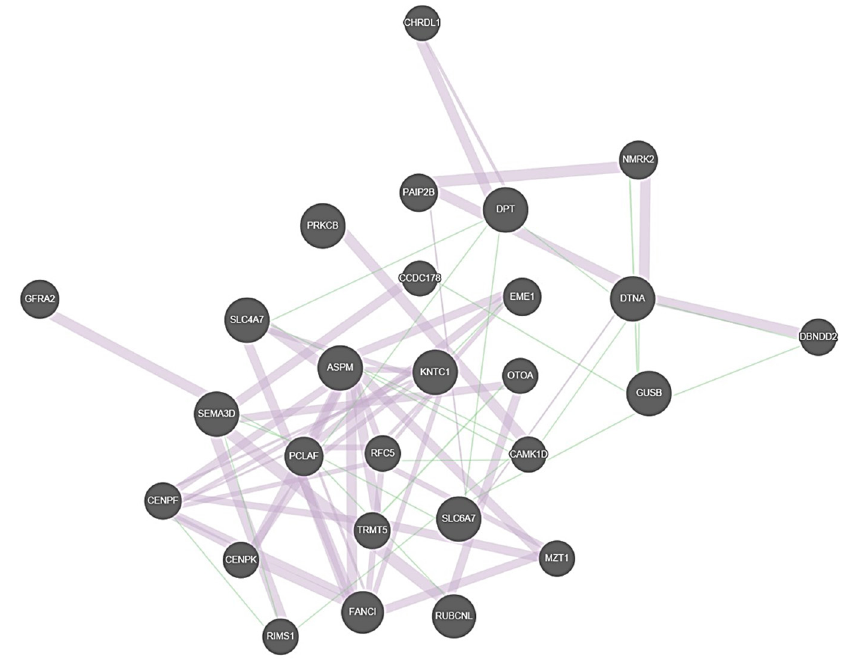
Figure 3. Illustration of the co-expression network between the familial MD candidate genes. Thick purple lines represent co ‐ expression and thin green lines genetic interactions. Genes that were provided as input in GeneMANIA software are marked with cross ‐ hatched circles of a uniform size. Genes added as relevant interactors by the software are shown with solid circles whose size is proportional to the number of interactions they have.